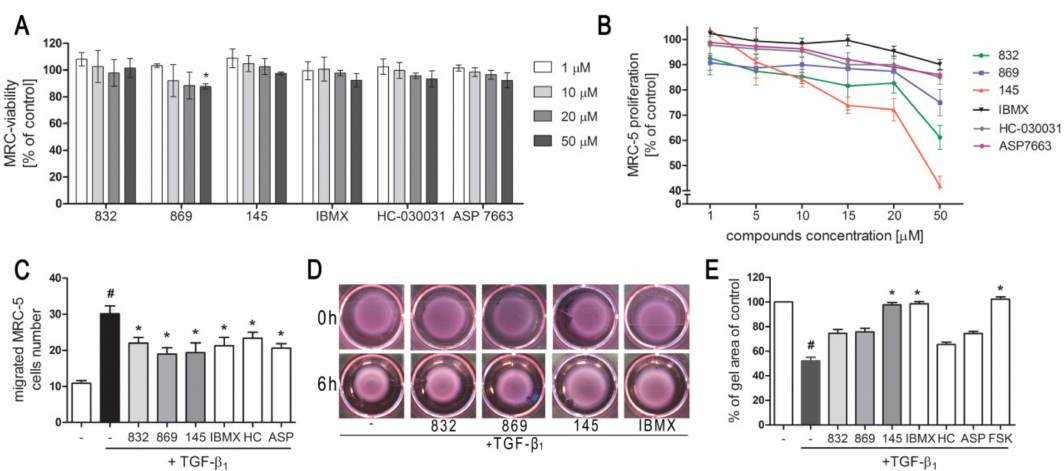
Figure 2. Compounds 832, 869, and 145 disturb FBS or TGF- β 1 -induced MRC-5 cells remodeling phenotype. ( A ) Lung fibroblasts were cultured in growing concentrations of 832, 869, 145, IBMX, HC-030031, and ASP7663 (1–50 µ M) for 48 h. A viability assay was performed with CYTO-Tox